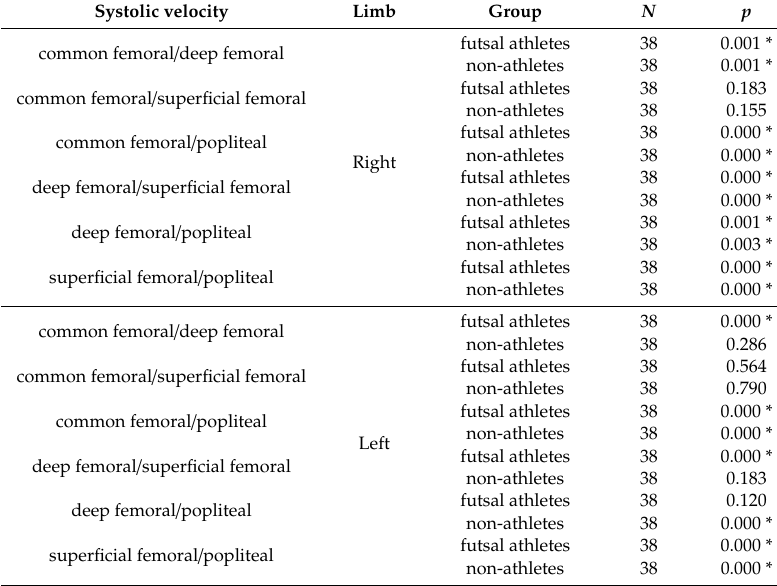
Table 2. Pairwise comparisons in systolic velocities between arteries in right and left limbs on non-athletes and futsal